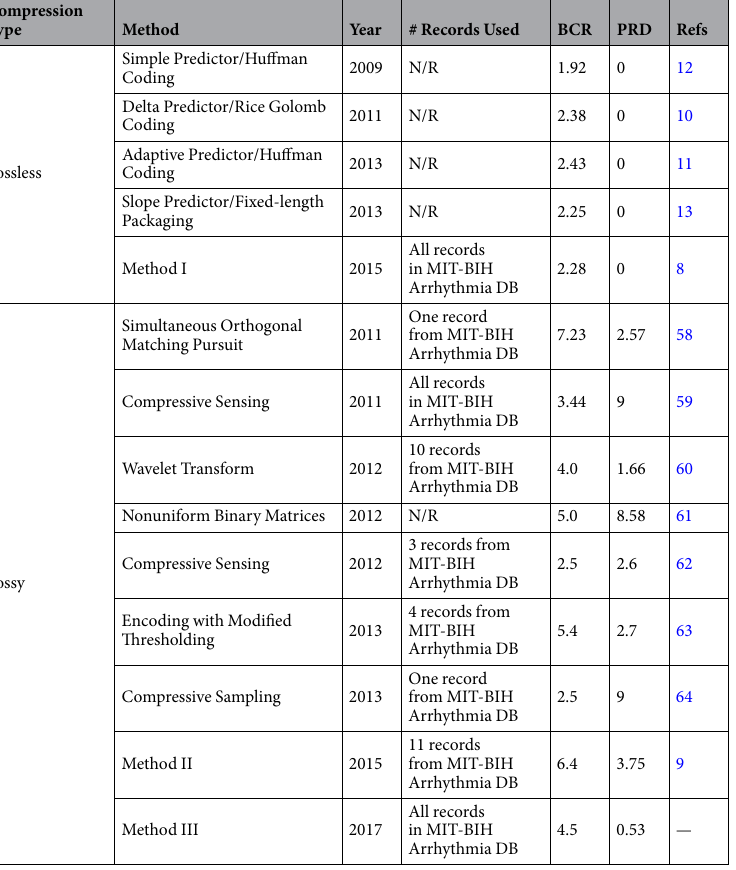
Table 4. Compression performance comparison with other algorithms. BCR stands for bit compression ratio, PRD stands for percentage root-mean-square difference, N/R stands for Not Reported, and the symbol ≈ means nearly equal.